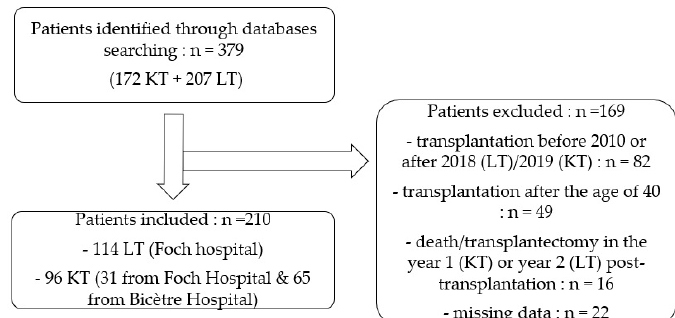
Figure 1. Figure 1. Flowchart.